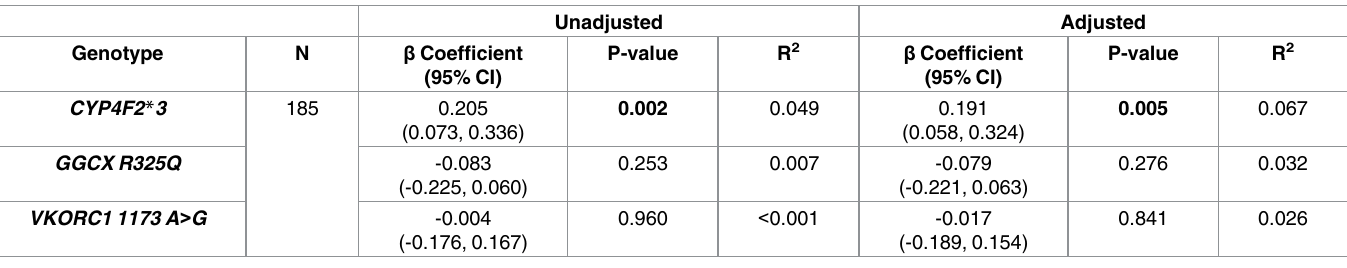
Table 4. Association of plasma vitamin K with CYP4F2 , GGCX and VKORC1